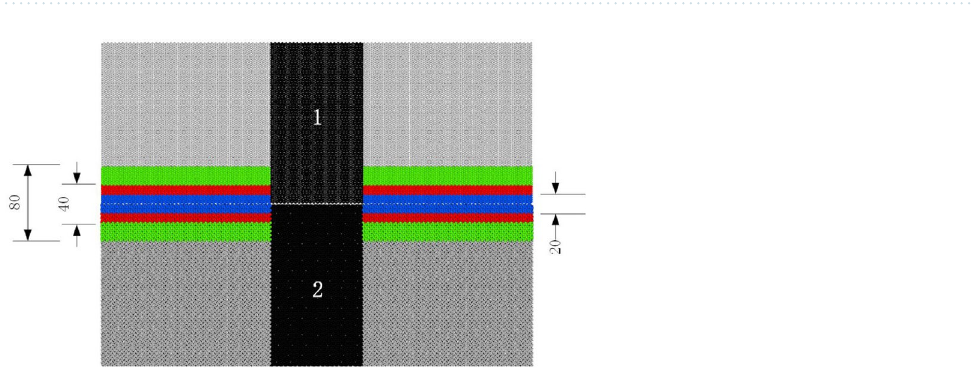
Figure 10. Definition of cohesive zone at atomic